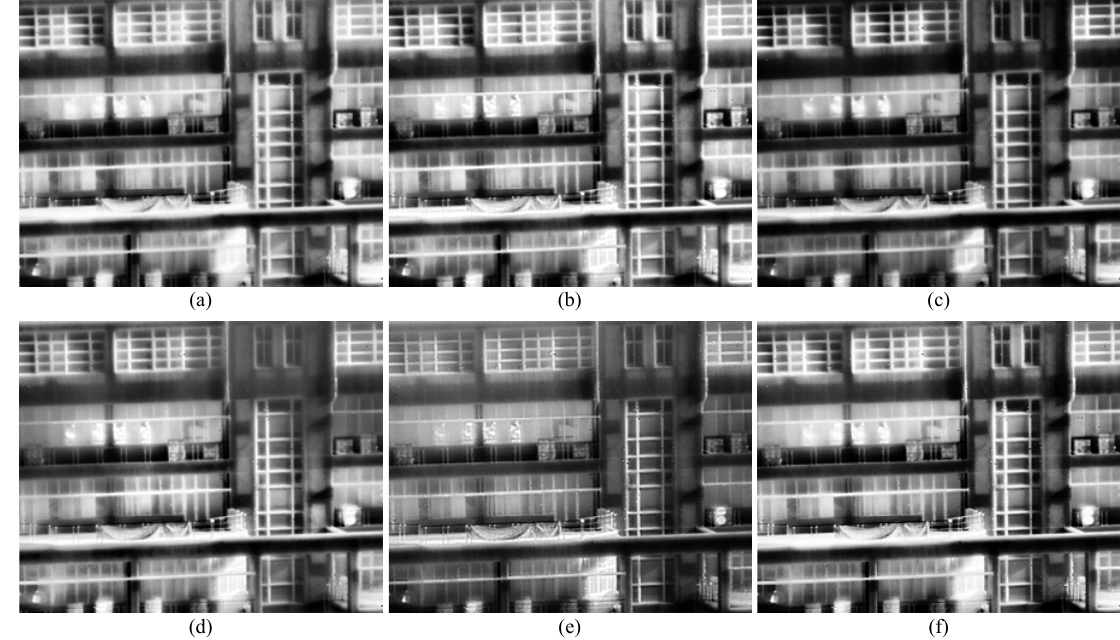
Figure 13. Enhancement results for Windows. ( a ) CLAHE, ( b ) BCCE, ( c ) ABMHE, ( d ) LGGSF, ( e ) GLHS, ( f ) Proposed.